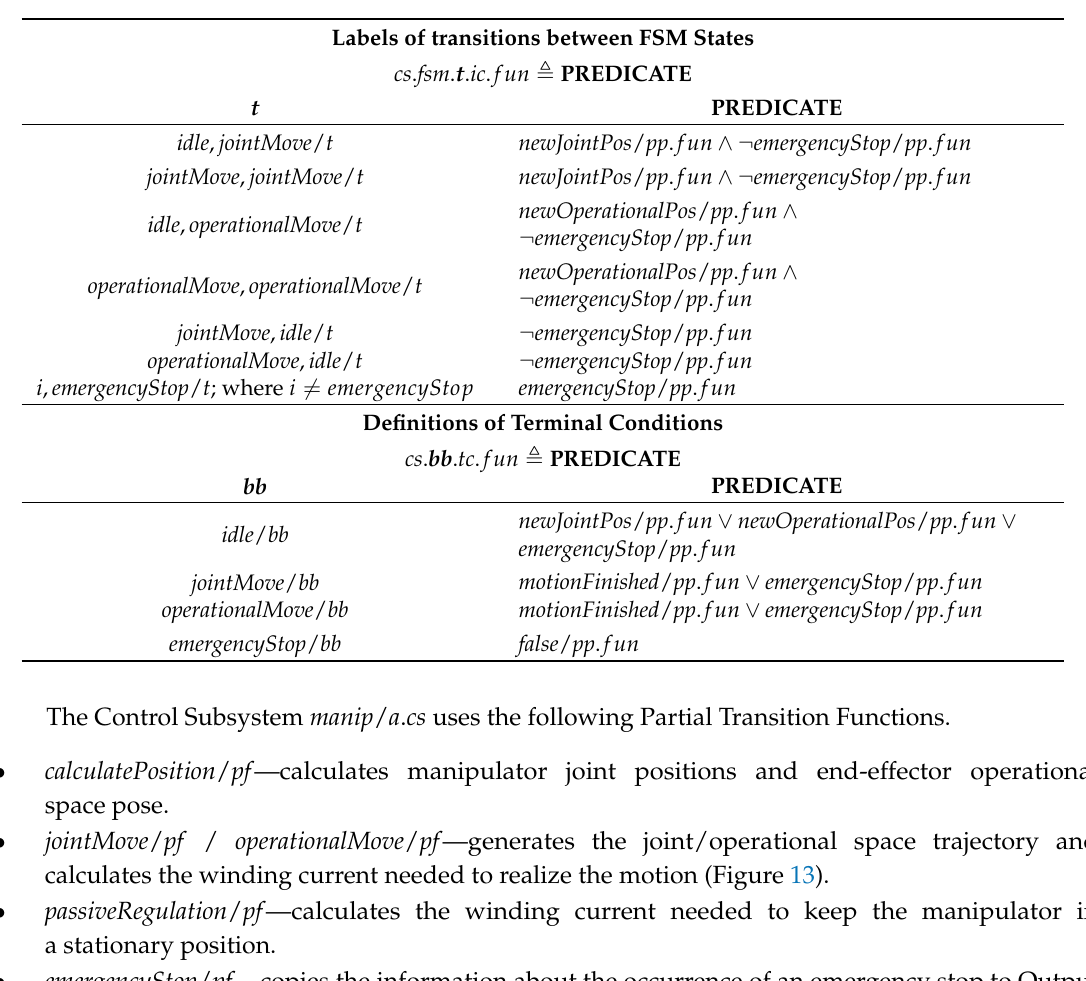
Table 6. Initial conditions labelling manip / a . cs . fsm transitions and terminal conditions of manip / a . cs . bb . It is assumed that task / a can not set simultaneously a new joint position and an operational space pose.